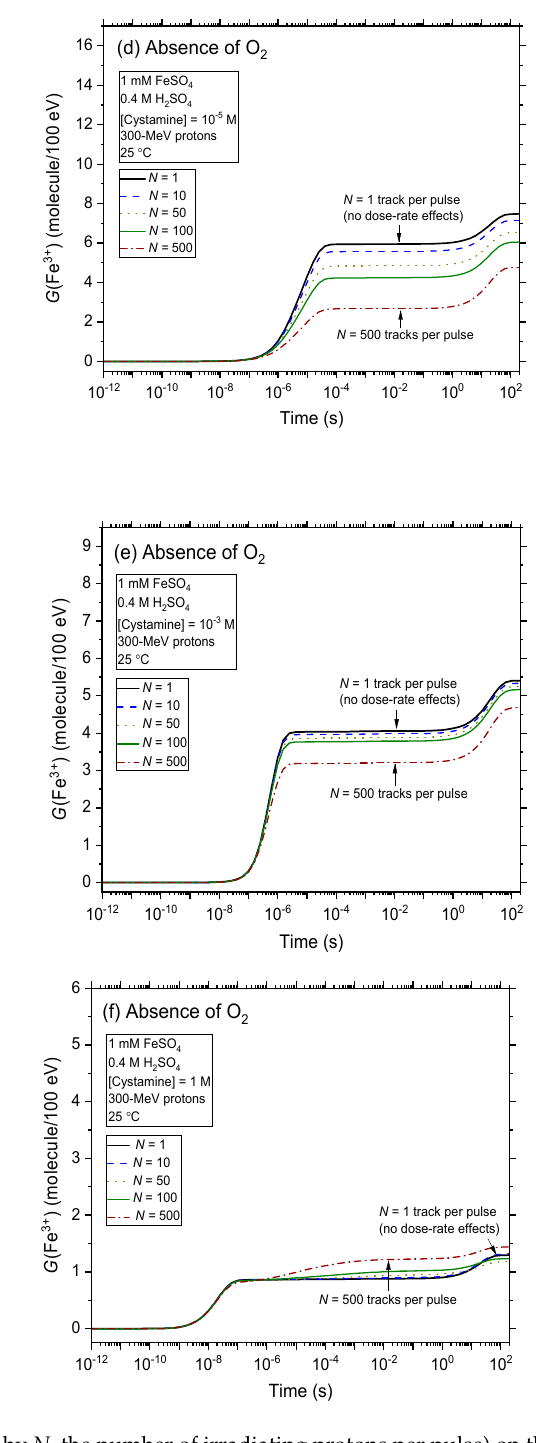
Figure 4. Effect of dose rate (described by N , the number of irradiating protons per pulse) on the time evolution of G (Fe 3+ ) obtained from our Monte Carlo simulations of the radiolysis of aerated (panels ( a – c )) and deaerated (panels ( d – f )) Fricke-cystamine solutions containing various concentrations of cystamine (10 − 5 , 10 − 3 , and 1 M), using 300-MeV incident protons at 25 ◦ C. Data for N = 1 corresponds to the absence of dose-rate effects and are used as a reference. For clarity, only the curves for N = 1, 10, 50, 100, 500, and 1000 are shown here.